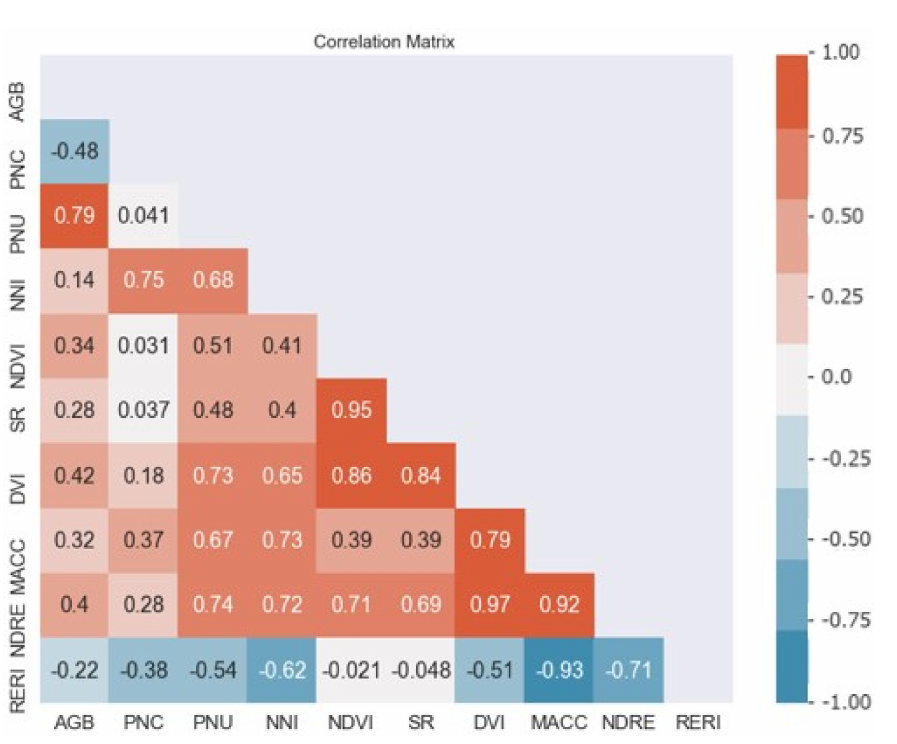
Figure 1. The Pearson correlation coefficient metric between five vegetation indices (Table 1) and corn N status indicators (AGB = aboveground biomass, PNC = plant N content, PNU = plant N uptake, and NNI = N nutrition